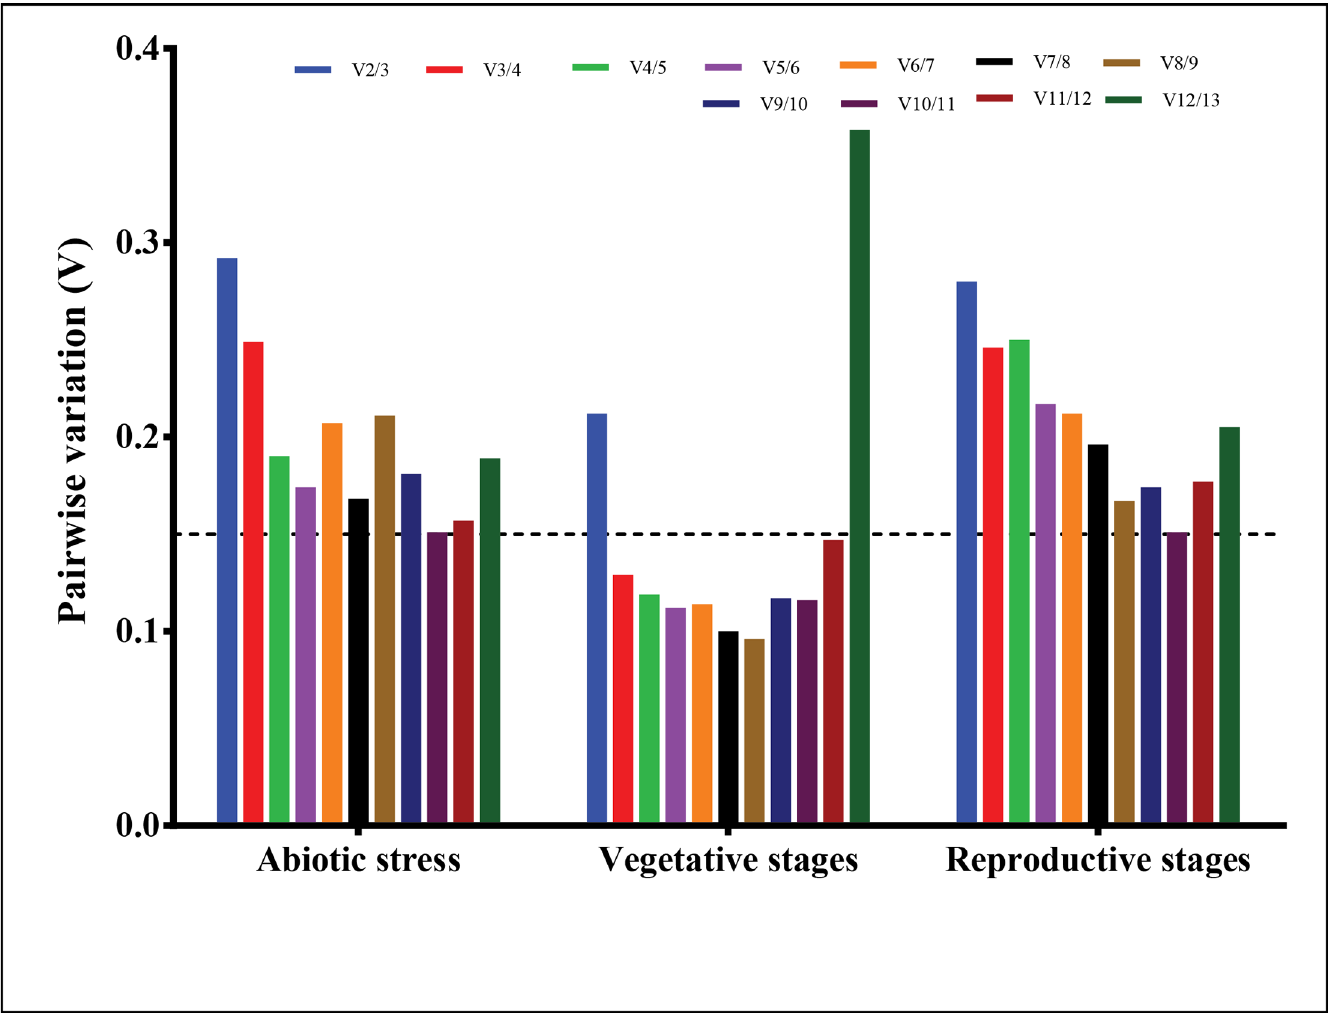
Fig 4. Optimal number of referencesgenes required for normalization across different experimental sets as calculated by geNorm. Dotted line indicatescut-off value of 0.15, below which additionalreference genes are not necessary for normalization.